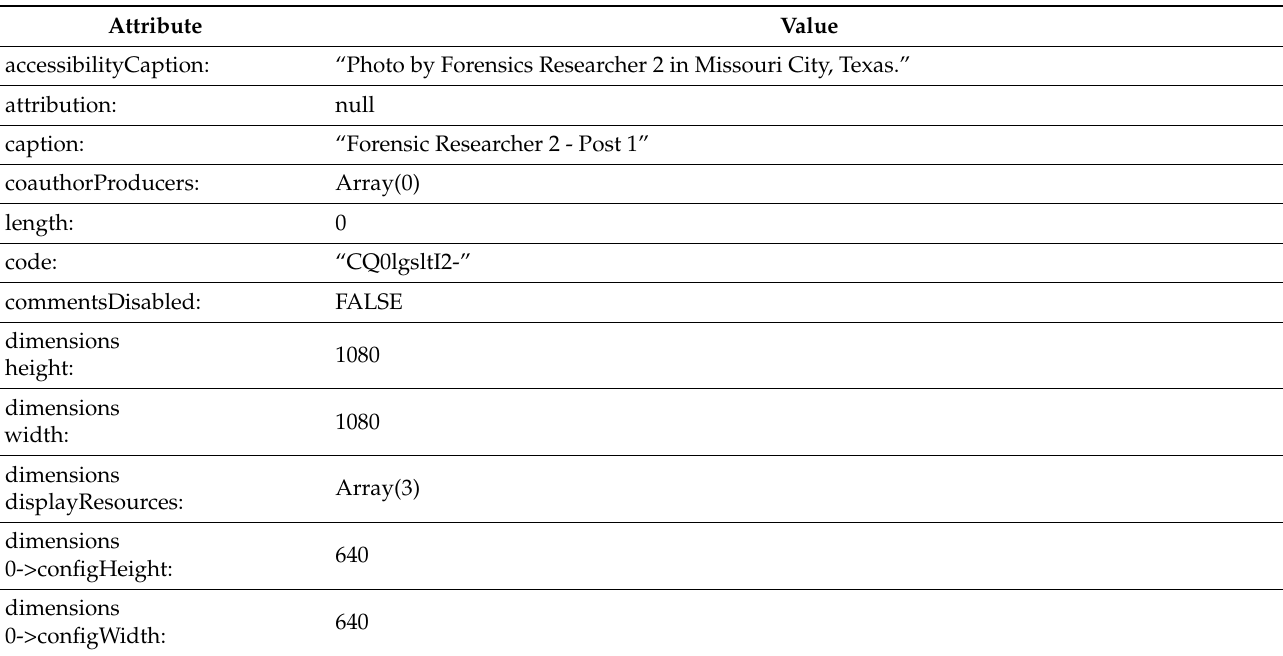
Table A2. Full List of Artifacts and Their Fields Found in posts.byId